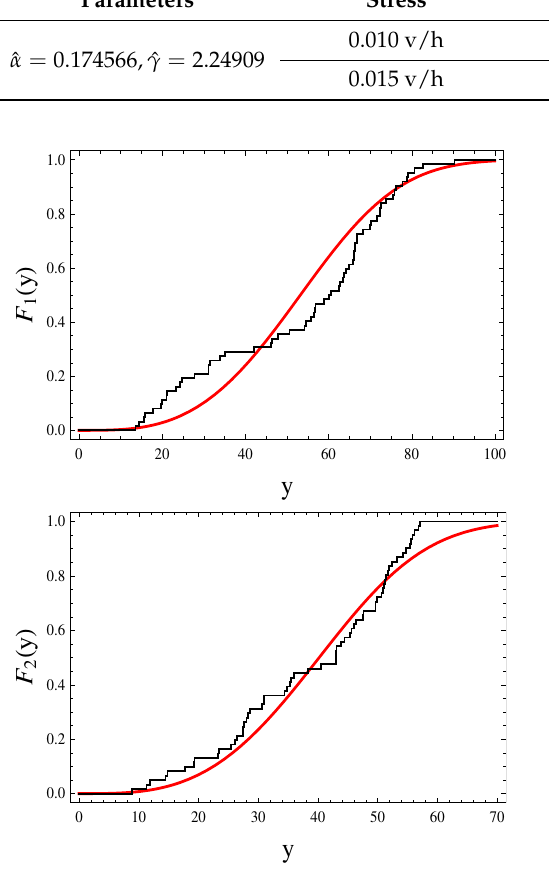
Figure 2. Empirical CDF (black line) versus CDF of Weibull distribution (red line) for the data given in Table 3, under two stress